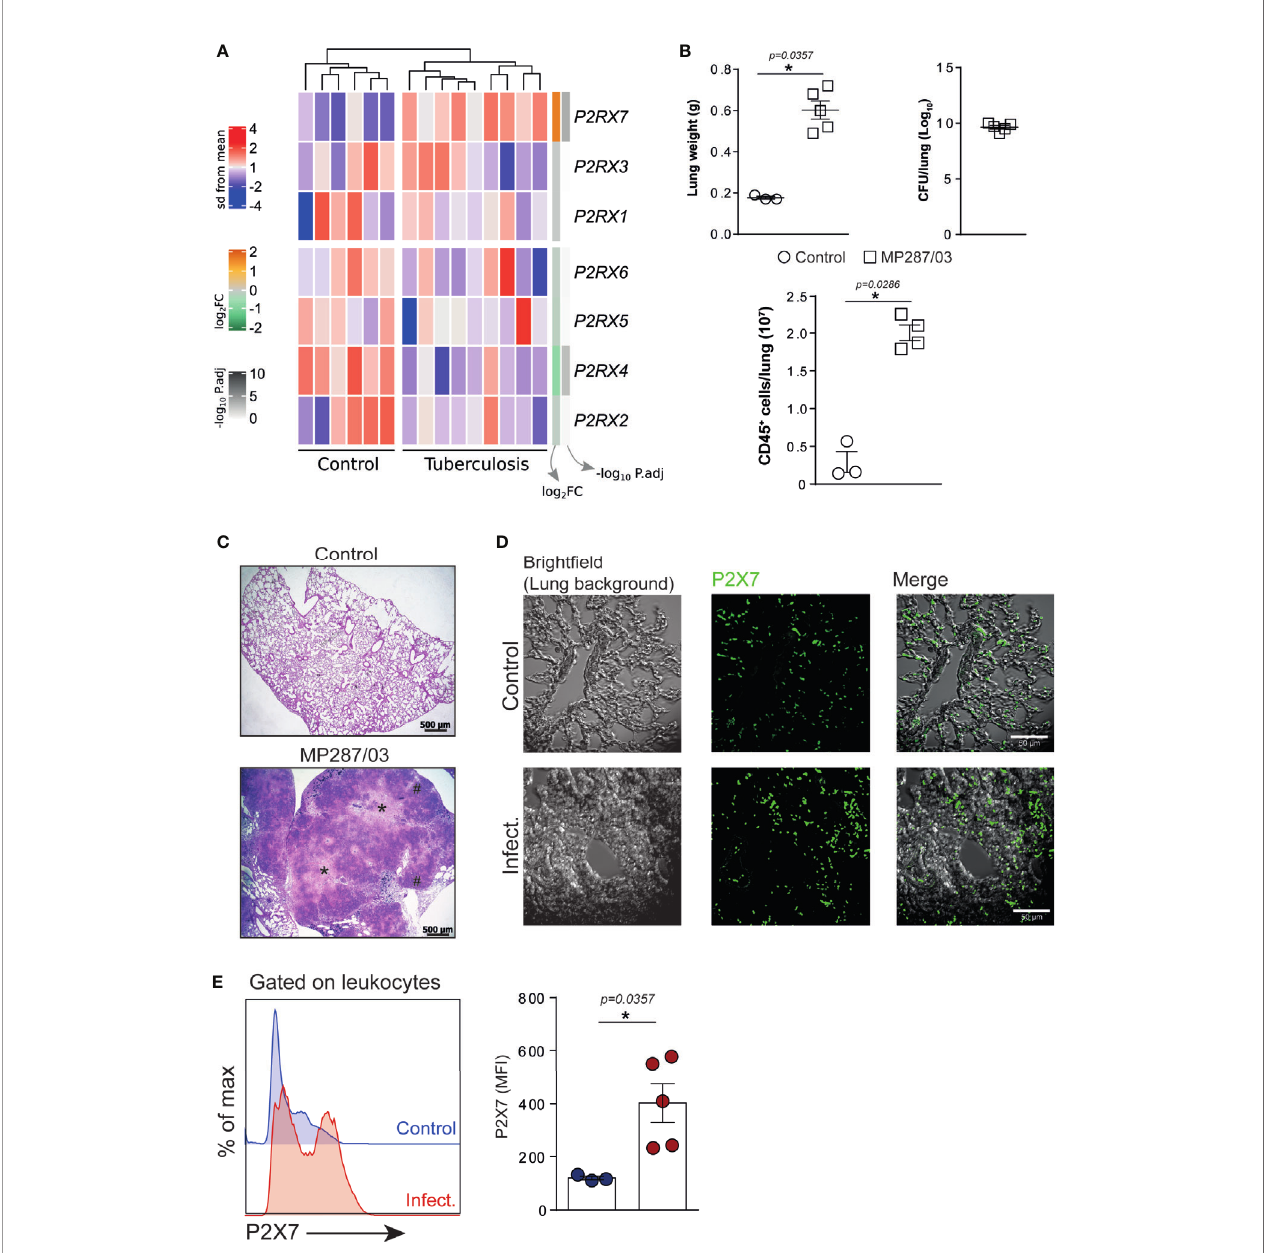
FIGURE 1 | The expression of P2RX7 gene and P2X7 receptor is increased in the peripheral blood of TB patients and on lung leukocytes of mice with severe TB. (A) Gene expression counts were z-score normalized across all samples. Log 2 fold-change and -log 10 P. adjust from DEG analysis are shown in the right annotation of the heat map. Genes were ordered by hierarchical clustering (Euclidean distance). (B – E) C57BL/6 mice were infected i.t. with ~100 MP287/03 bacilli. Uninfected mice were used as control group. Mouse lungs were evaluated at day 28 of infection. (B) Lung weights, CFUs per lung and leukocyte (CD45 + ) cell numbers per lung are shown. (C) Representative lung sections stained with hematoxylin-eosin method (scale bars correspond to 500 µm) of infected and control group. Asterisks (*) indicate necrotic areas and hash signs (#) indicate alveolitis. (D) Immuno fl uorescence staining for the P2X7 receptor (green) in representative lung sections (scale bars correspond to 50 µm). (E) Histograms show P2X7 expression in lung leukocytes. Mean fl uorescence intensities (MFIs) of P2X7 expression are shown in the bar graph. Signi fi cant differences were observed between indicated groups with * p < 0.05, using Mann-Whitney non-parametric T test. Data are representative of two independent experiments with three to fi ve mice in each